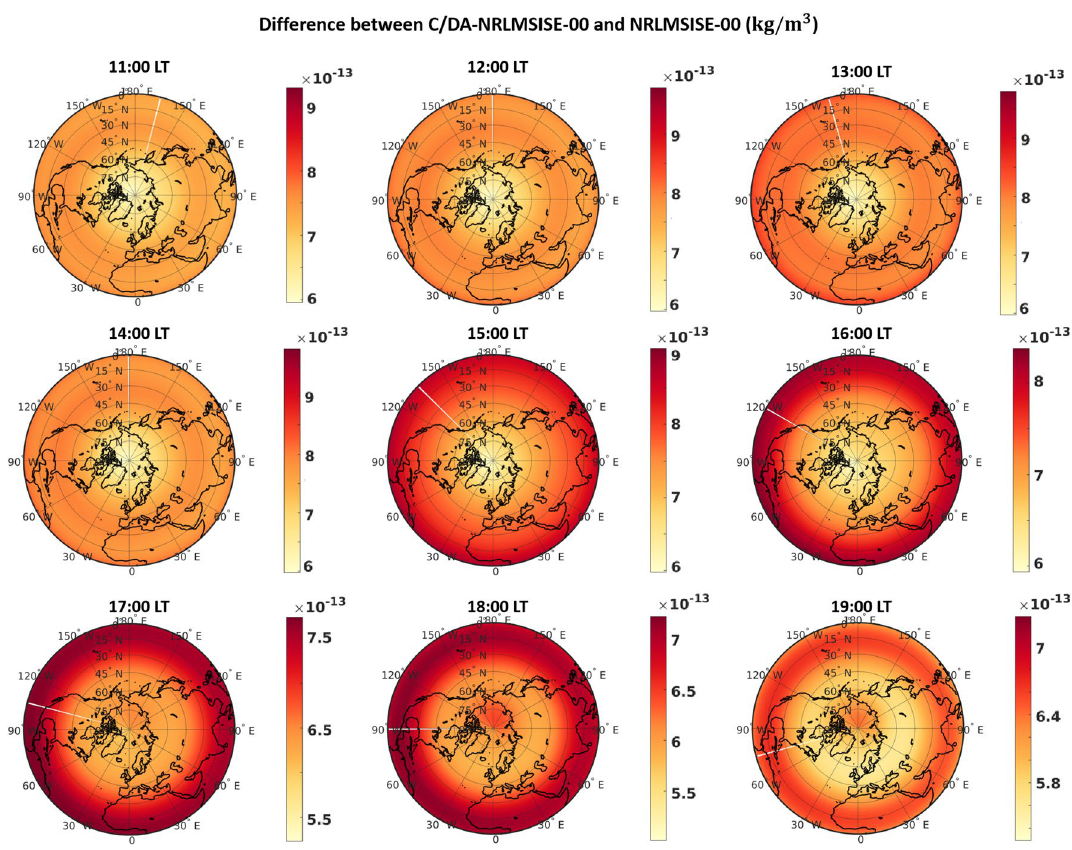
Figure 9. Thermosphere neutral density (TND) maps at the altitude of 450 km derived from the original NRLMSISE-00 (plots on left) and C/DA-NRLMSISE-00 (plots on middle) during 12 to 18 h local time (LT) on February 8th, 2015. The plots on the right correspond to the relative error (RE) maps that illustrate the impact of C/DA on representing the equatorial thermosphere anomaly (ETA). MATLAB (version R2021a, https:// www. mathw orks. com/) was used to generate these